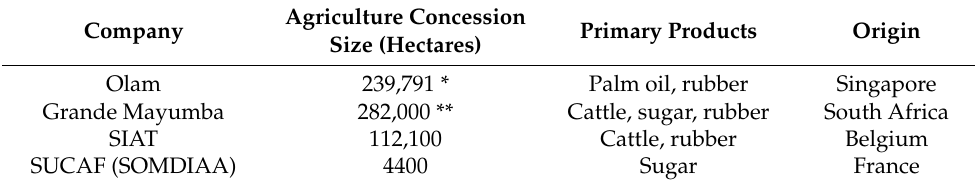
Table 2. Known agriculture concessions in